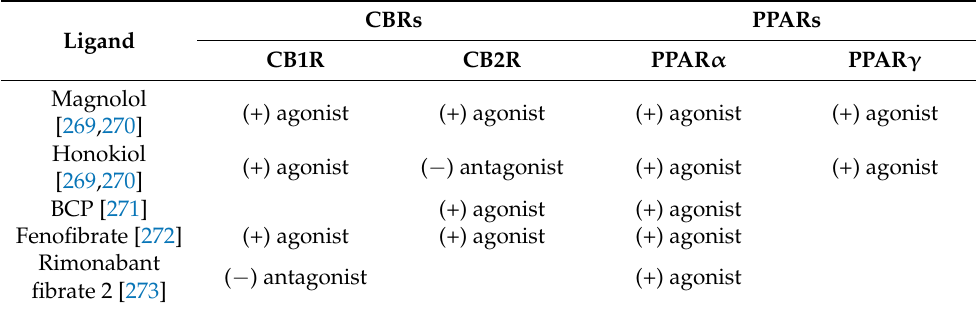
Table 4. Non-cannabinoid dual ligands of CBRs and